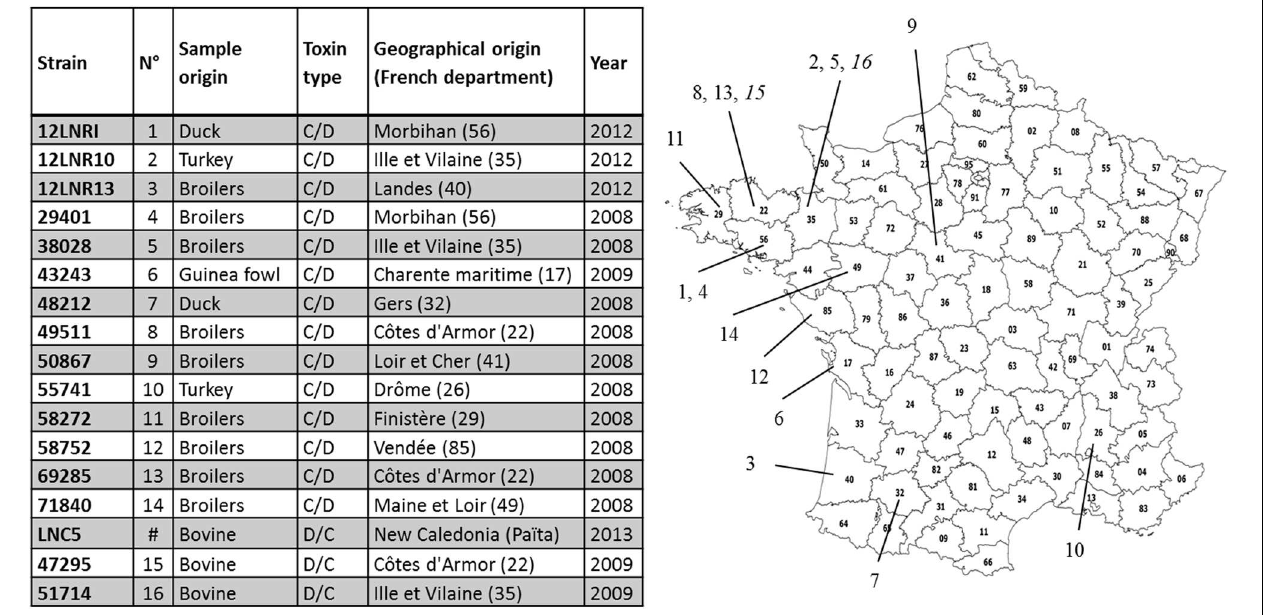
FIGURE 1 | Metadata for the isolated and sequenced Clostridium botulinum group III strains. The numbers in brackets correspond to the French departmental code (geographical location of the outbreak associated with the strain recovered). They are indicated on the map of France. The location of the two French outbreaks of type D/C are indicated in italics (numbered 15 and